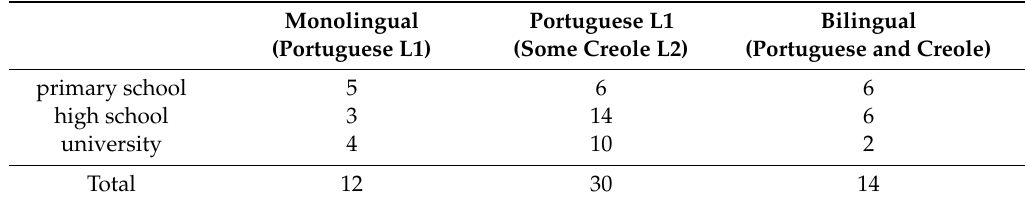
Table 2. Cross-tabulation between level of education and spoken languages (number of